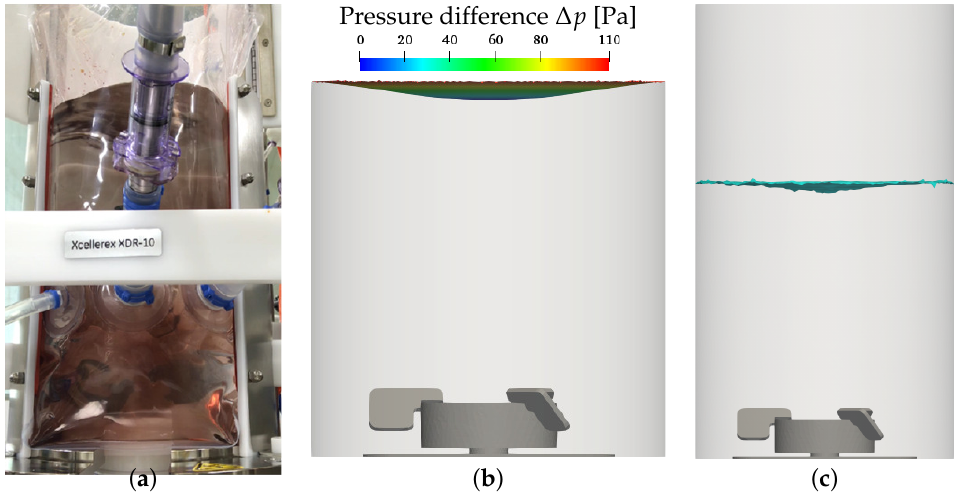
Figure 5. Surface vortex formation for 7.0 L, 100 rpm, 0.25 Lmin − 1 , 2 µ m, experiment without sparging. ( a ) Experiment; ( b ) Euler–Lagrange results; ( c ) Euler–Euler results, α l =